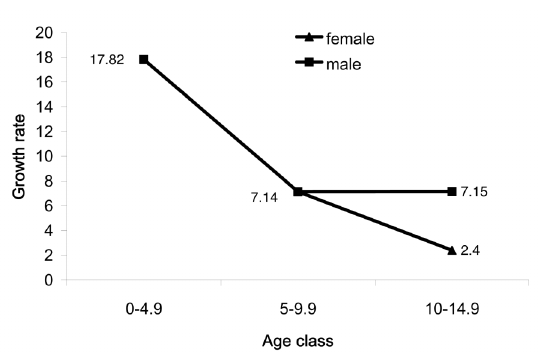
Fig. 8. Growth rates during the first 15 yr of life for male and female